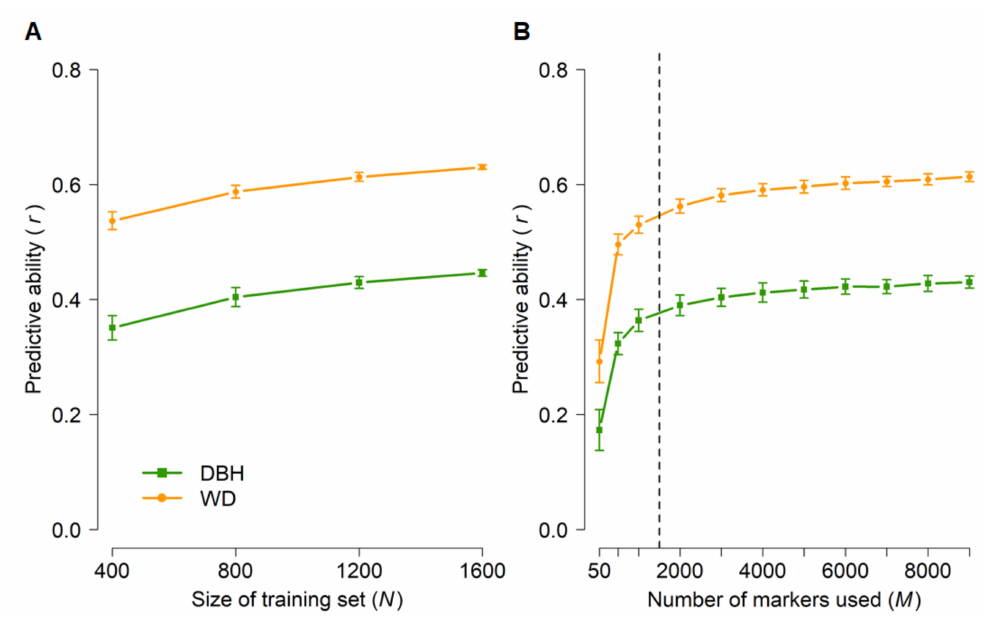
Figure 4. Genomic predictive abilities for diameter at breast height (DBH) and wood density (WD) as a function of training set size ( A ) and number of markers ( B ) used in random cross-validations of 1761 radiata pine genotypes from five populations (Table 1). Error bars correspond to standard deviations across 100 random cross-validations for each set of parameters. Analyses in ( A ) were based on all 9353 markers. The training set size in ( B ) was N = 1200 and subsets of markers were selected at random. Predictive abilities were calculated based on the predicted and observed values of all 1761 genotypes, after data had been split randomly into k folds until a predicted value was available for each genotype (see Materials and Methods and Table 1). The dashed line in ( B ) indicates the plateau in predictive